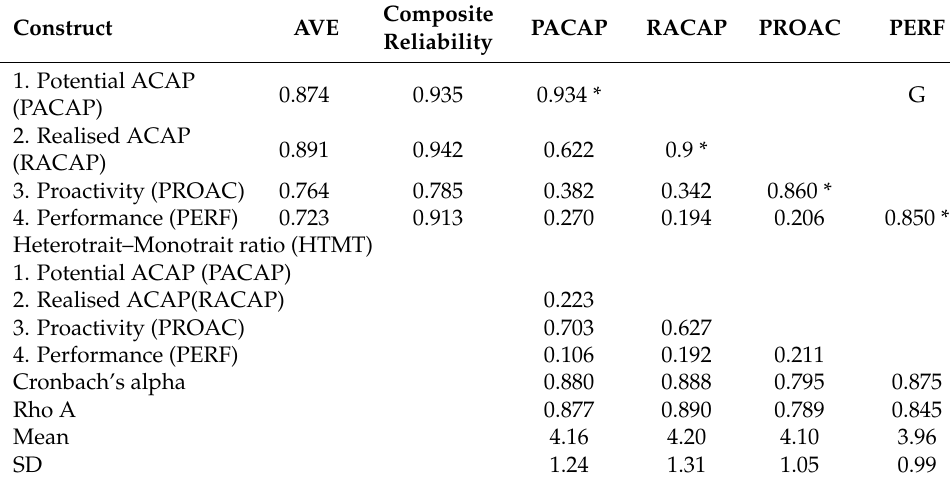
Table 4. Correlation matrix, composite reliability, convergent and discriminant validity, heterotrait– monotrait ratio (HTMT) and descriptive